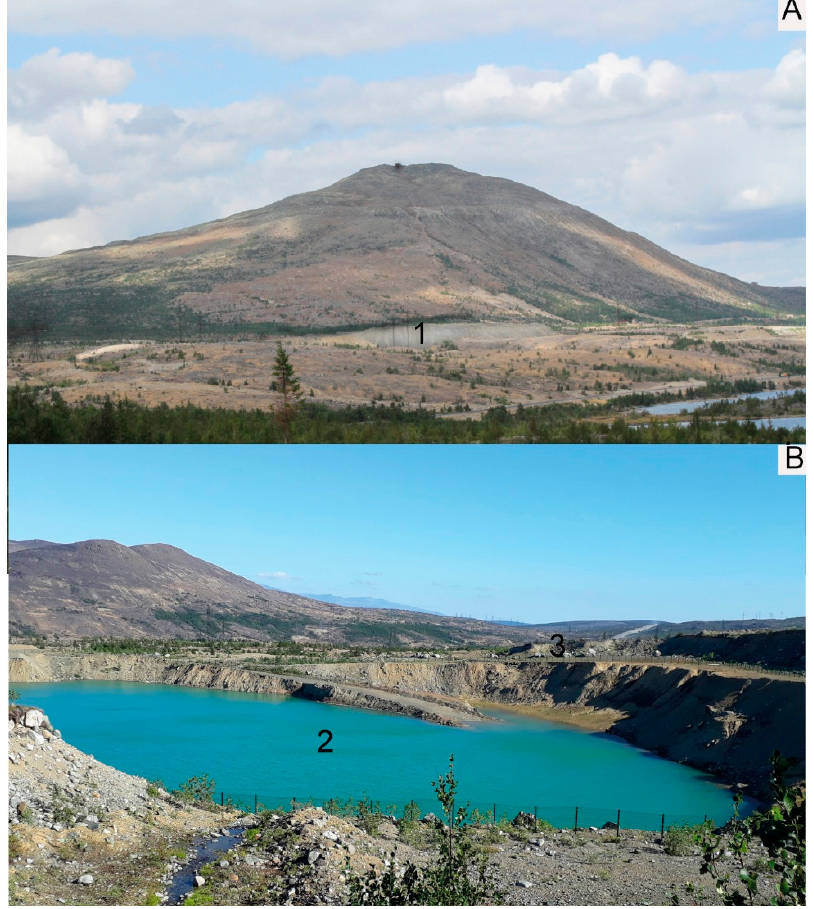
Figure 1. Panorama of Mt. Nittis: ( A )—(1) A quarry of the Sopcheozero deposit and overburden dumps; ( B )—(2) In 2015, the quarry was filled with water; (3) Large fragments of Cr-spinel ores and host dunites have been preserved on its terrace.